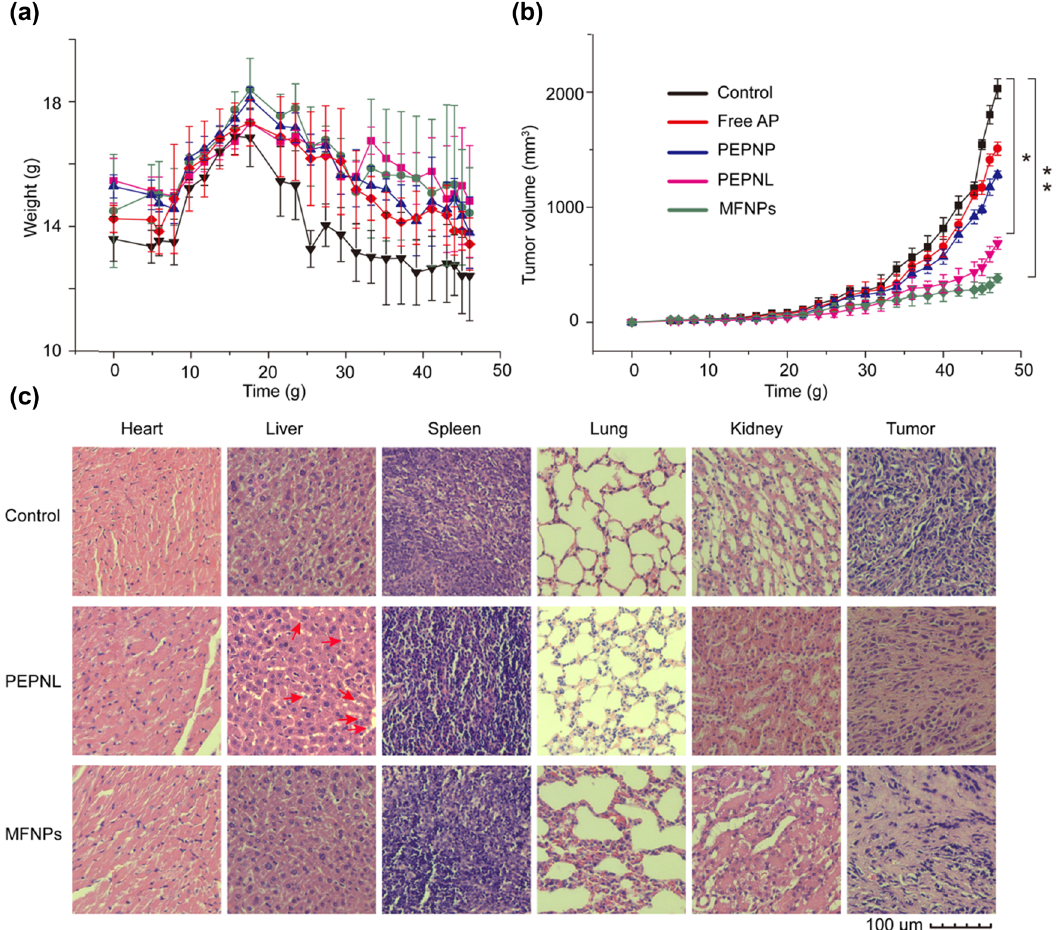
Figure 5: ( a ) Body weight and ( b ) tumor volume in tumor - bearing BALB/c mice following intravenous administration of control, free AP, PEPNP, PEPNL, and MFNPs groups. ( c ) Organ and tumor sections after 30 days of administration of control, PEPNL and MFNPs groups. Data are presented as mean ± SD ( n = 3 ) , and statistical analyses were performed using a two - sided Student ’ s t - test ( * p < 0.05, ** p < 0.01, *** p < 0.001 )